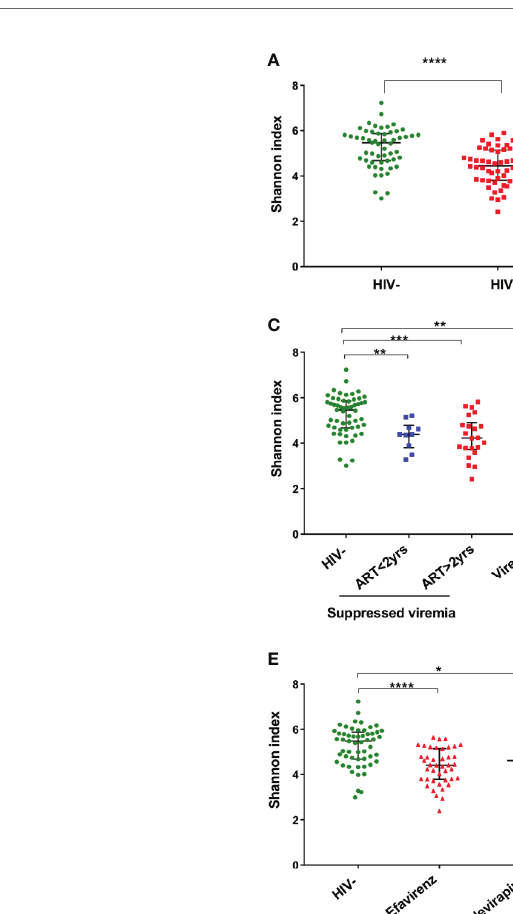
( Figure 6 ). Plasma LBP levels did not show signi fi cant correlation with I-FABP or sCD14 but were correlated negatively with CD4 counts ( p < 0.005, r = -0.38) and CD8 counts ( p < 0.05, r = -0.32) and positively with plasma viral load ( p < 0.05, r = 0.39) ( Figure 6 and Supplementary Figure 4 ). These microbial translocation markers exhibited no signi fi cant correlation with alpha diversity of fecal microbiome ( Figure 6 ). However, the alpha diversity showed a moderate but signi fi cant positive correlation with CD4 count (Faith_pd: p < 0.05, r = 0.28; Shannon: p < 0.05, r = 0.27) ( Figure 6 and Supplementary Figure 4 ). In all the genera identi fi ed to be more abundant in HIV+, the relative abundance showed a trend of negative correlation with